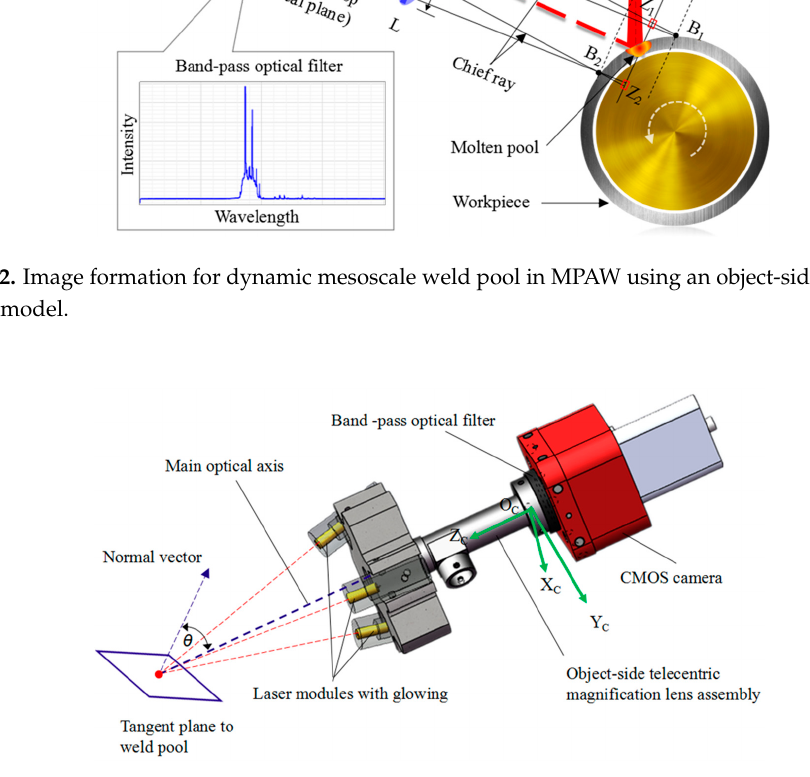
Figure 3. The configuration of the designed passive micro-vision sensing sensor.